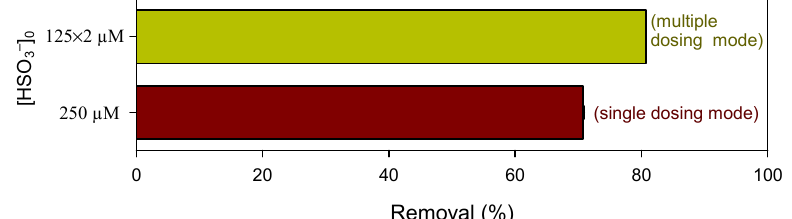
Figure 2. ( A ) Time course of Mn(III) (50 µM) reduction by HSO 3 − (2000 µM); ( B ) linear relationship between measured pseudo-first-order rate constants ( k obs , s − 1 ) and HSO 3 − concentrations. Conditions: [PP] 0 = 2.5 mM, pH = 7.0.